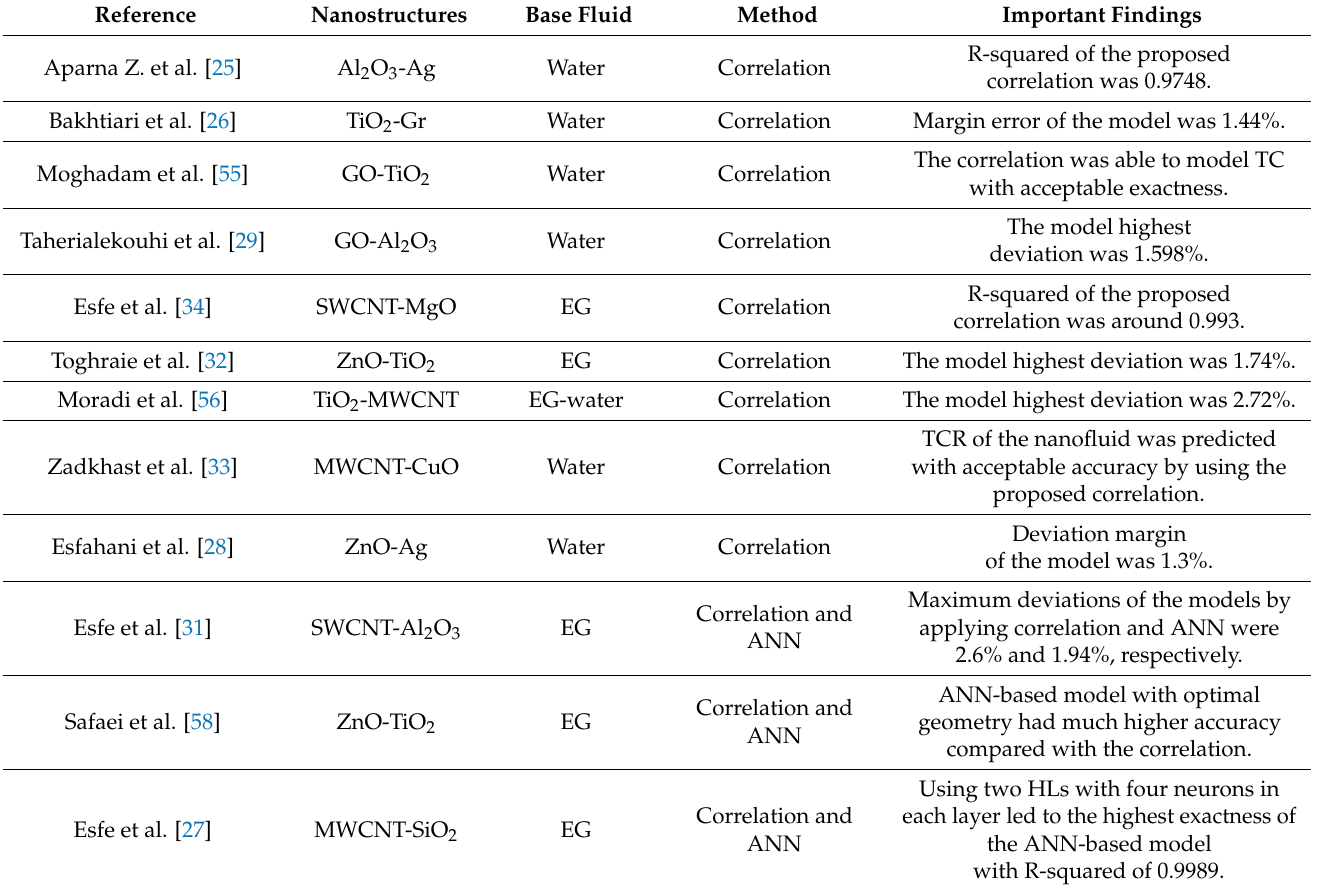
Table 2. Proposed models for TC of hybrid